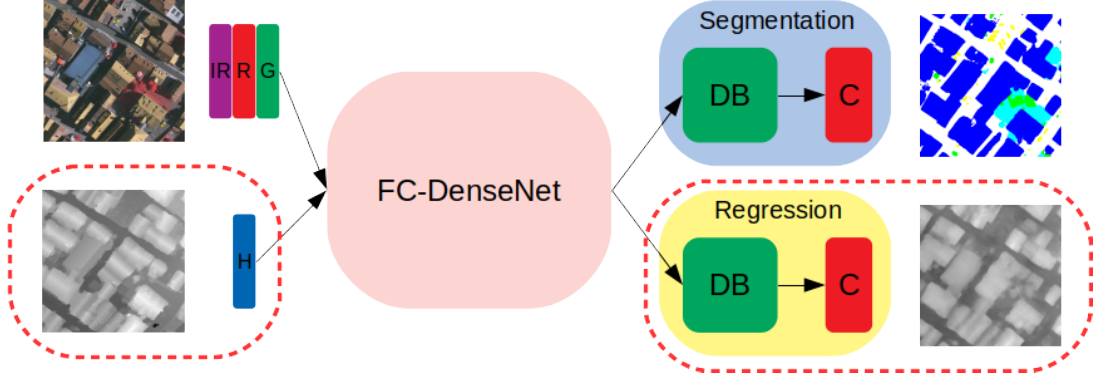
Figure 1. The architecture and its modifications. The red dashed parts are optional in an exclusive-or manner. Input channels: IR-R-G : infra-red, red and green, H : height. DB : dense block and C : convolutional layer. FC-DenseNet from (Jégou et al.,